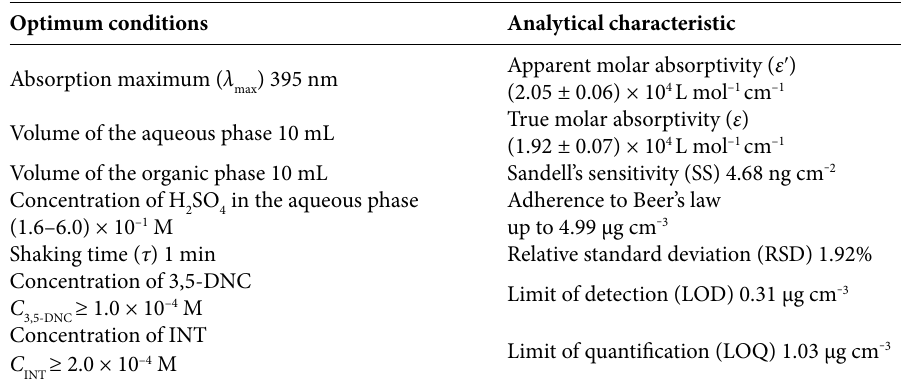
Figure 1. Absorption spectra of the complex Mo(VI)‒3,5-DNC‒ INT and of the blank sample 3,5-DNC‒INT in CHCl 3 C = 2.08 × 10 ‒5 M; C = 2.0 × 10 ‒4 M, C = 2.0 × 10 ‒4 M; Mo(VI) 3,5-DNC INT C Table 1. Optimum extraction-spectrophotometric conditions and analytical characteristics of the system